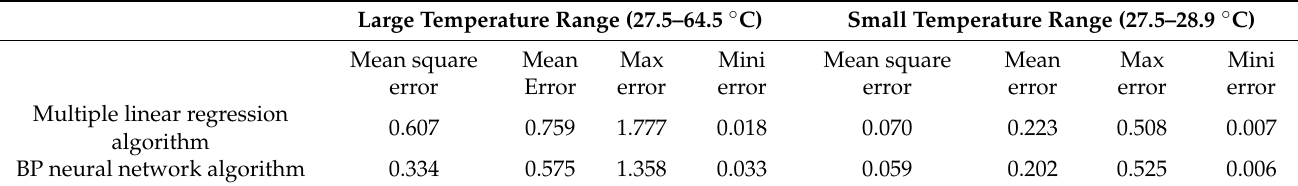
Table 8. The prediction results of multiple linear regression algorithm and BP neural network